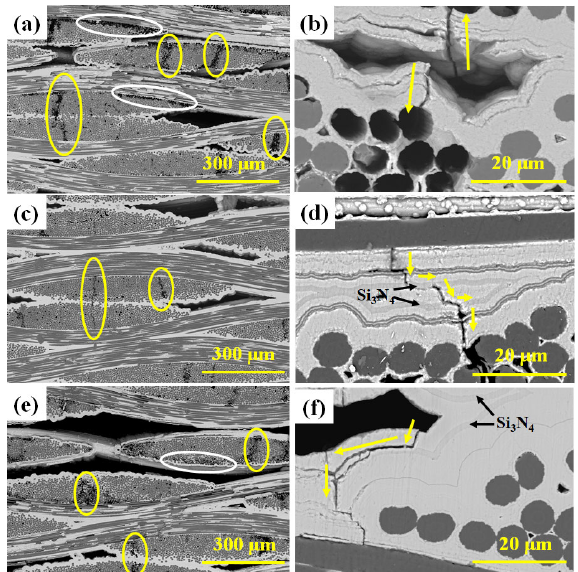
Fig. 6 BSE images of polished cross-sections of the as- prepared three composites after oxidation at 800 ℃ for 10 h: (a, b) sample S0, (c, d) sample S1, and (e, f) sample